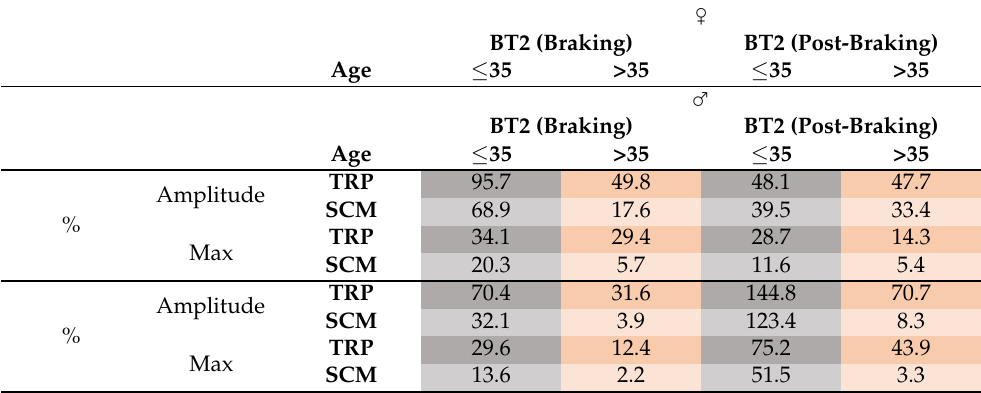
Table 7. sEMG parameters for BT2 (mean of the amplitude and maximum value reach) compute in the braking and post-braking phases (phase 2 and phase 3) sorted by age ( ≤ 35 and >35) and genre ( or ). P.P.O.M: Percentage of People Over the Mean; µ : mean value of the amplitude after ♀ ♂ normalisation